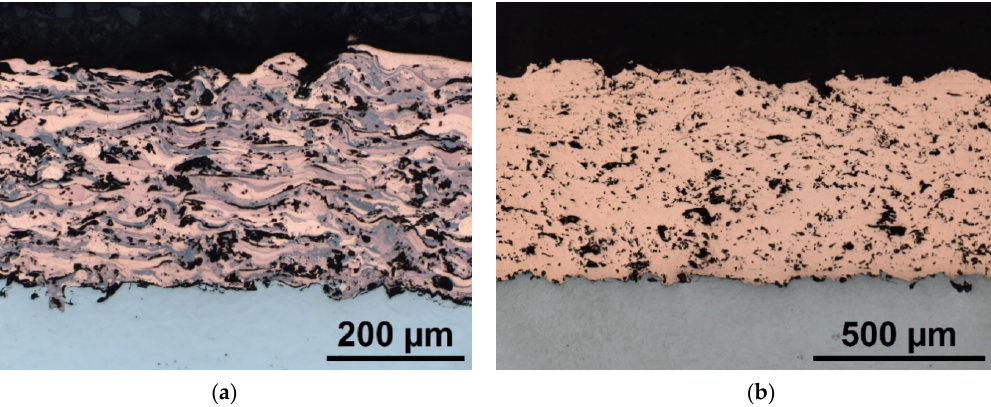
Figure 2. Optical micrographs obtained on cross-sections that depict the microstructures of the wire arc sprayed copper coatings applied in different environments: ( a ) conventional process in air; and ( b ) process with silane-doped